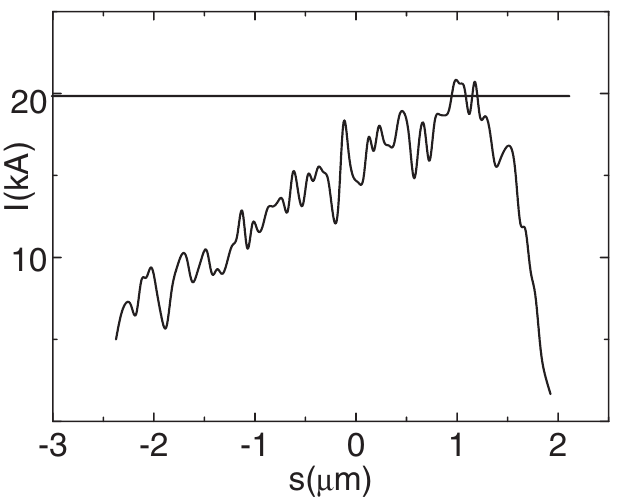
FIG. 5. Current I versus the coordinate along the bunch s in (cid:4) m